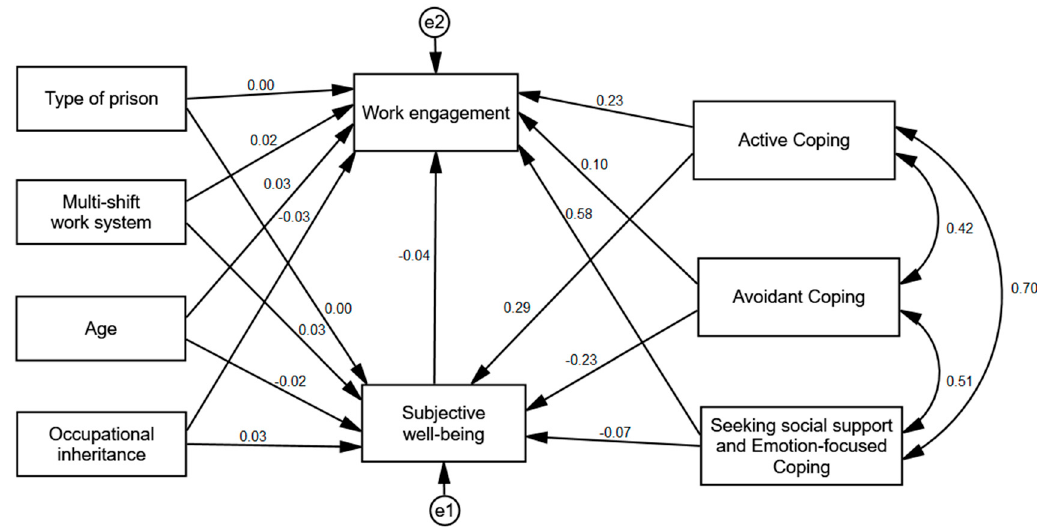
Figure 3. Standardized regression coefficients for the explanatory path model of work engagement in the group of Indonesian POs. the group of Indonesian POs.